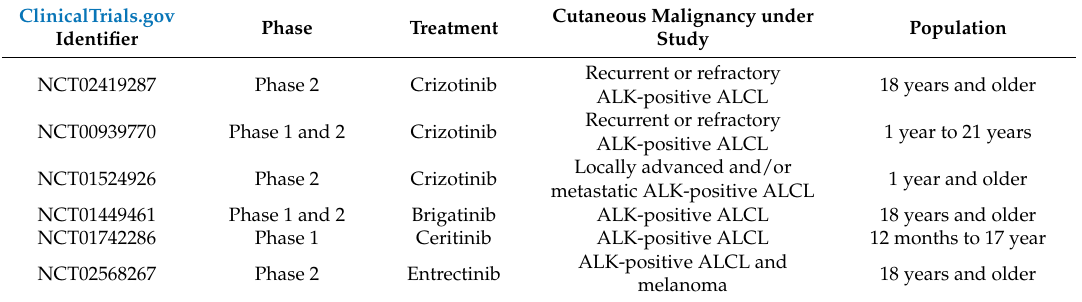
Table 2. Ongoing clinical trials investigating use of targeted therapies in ALK-positive cutaneous malignancies. ClinicalTrials.gov Phase Identifier